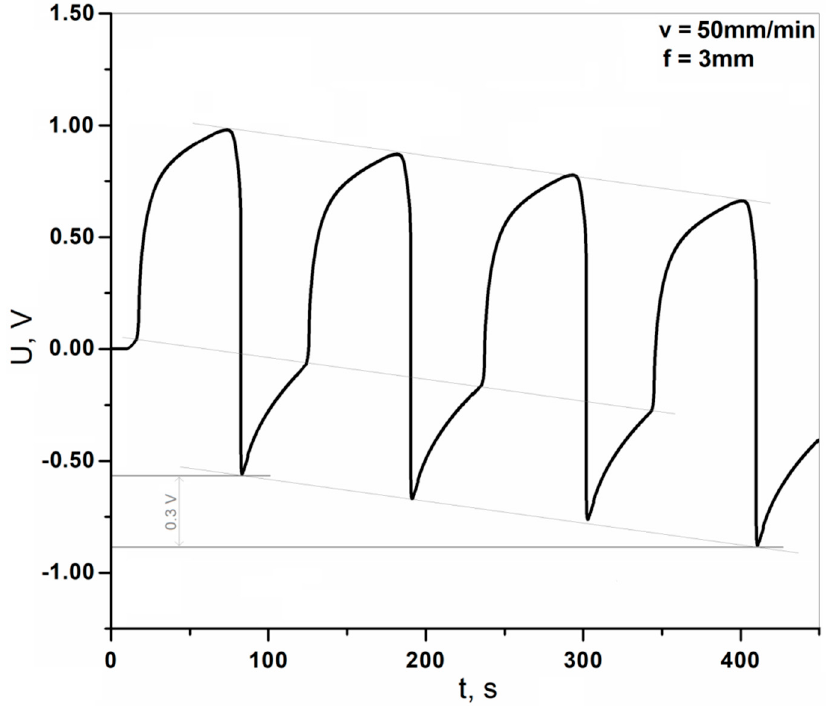
Figure 10. Voltage diagrams obtained during non-destructive static bending tests without waiting for sample discharge (deflection of 3.0 mm, bending rate of 50 mm/min).